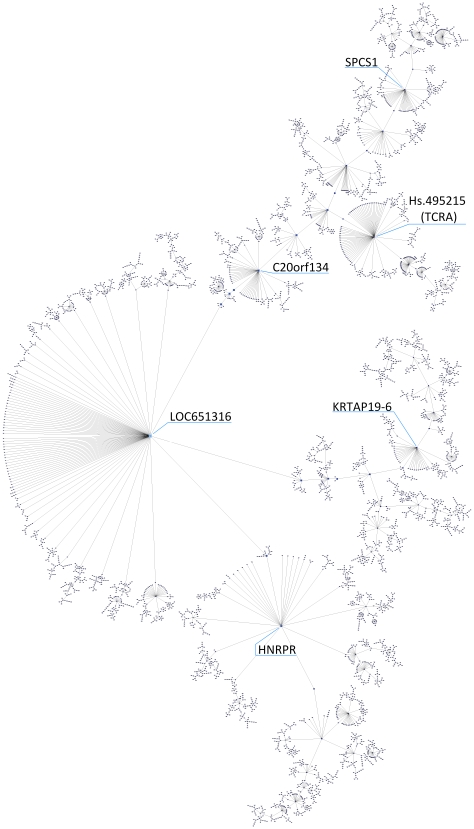
The largest cluster from
Figure 11
 with a different layout.Nodes represent probes, colour and size indicate its centrality in the graph (number of connected nodes). Some of the prominent “stars” have been labelled.